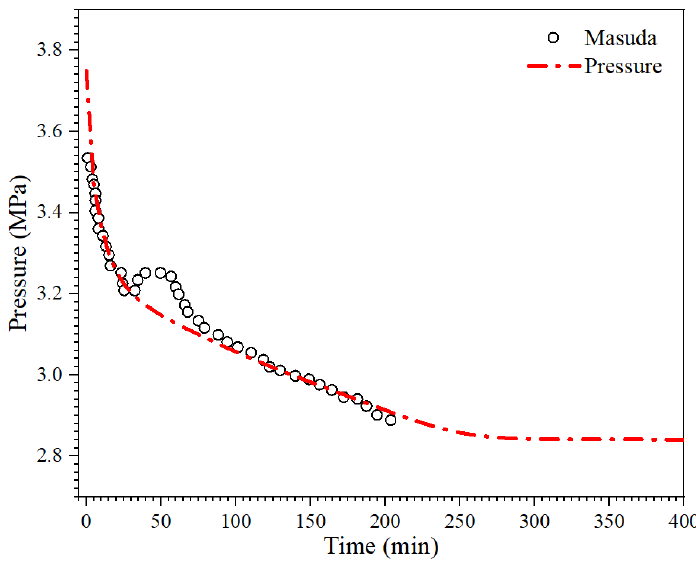
Figure 4. The pressure at the far-field boundary.